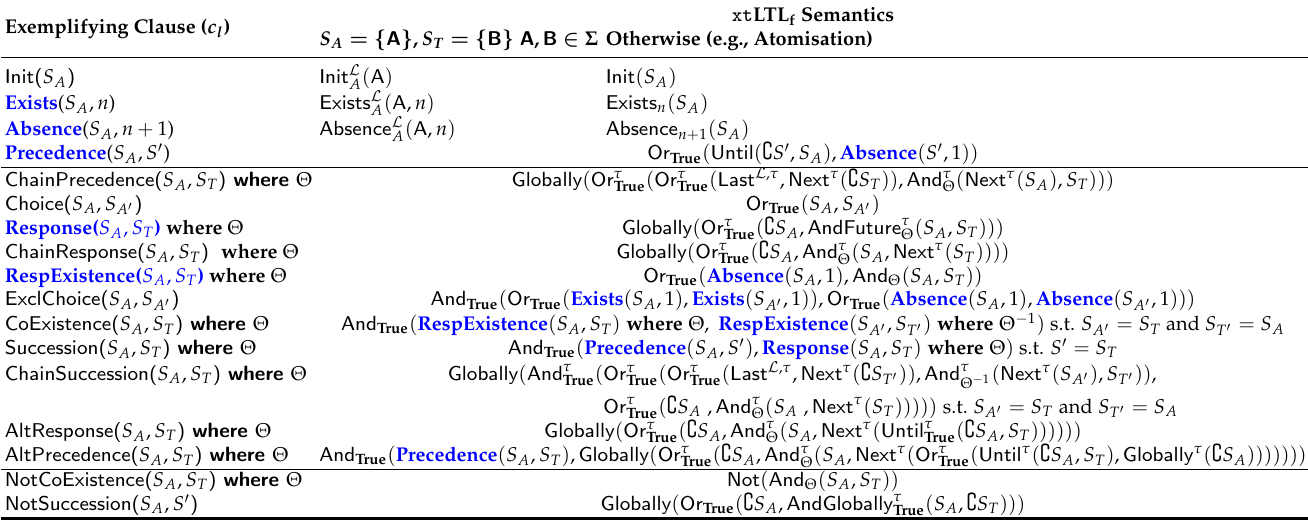
Table 5. Declare templates illustrated as their associated xt LTL f semantics. S A (and S T ) denote the disjunction of collected atoms and activity labels (represented as sets) associated with the activation (and target) condition. The Atomisation Pipeline will return these sets. For declarative clauses that can be directly represented as xt LTL f operators, we might have two different possible operators depending on the atomisation